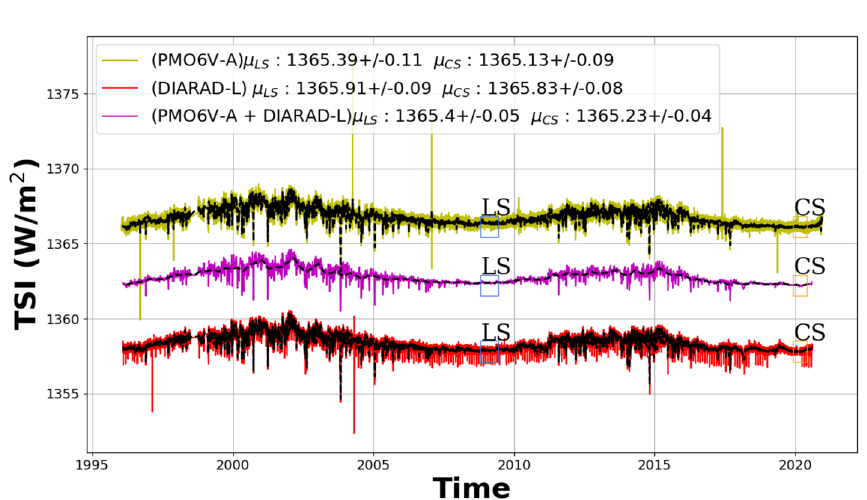
Figure 4. The new VIRGO TSI composite (purple) based on the fusion of the degradation-corrected DIARAD-L (red) and PMO6-VA (green). In the case of DIARAD, an extrapolated degradation curve was used to correct DIARAD-L after the failure of the backup channel (DIARAD-R) in 2017. Note that the last solar minimum (LS—blue box) and the current one (CS—orange box) are estimated for both 2008–2009 and 2019–2020. The time series are offset for clarity. In the inset we give the mean TSI values for each time series ( µ